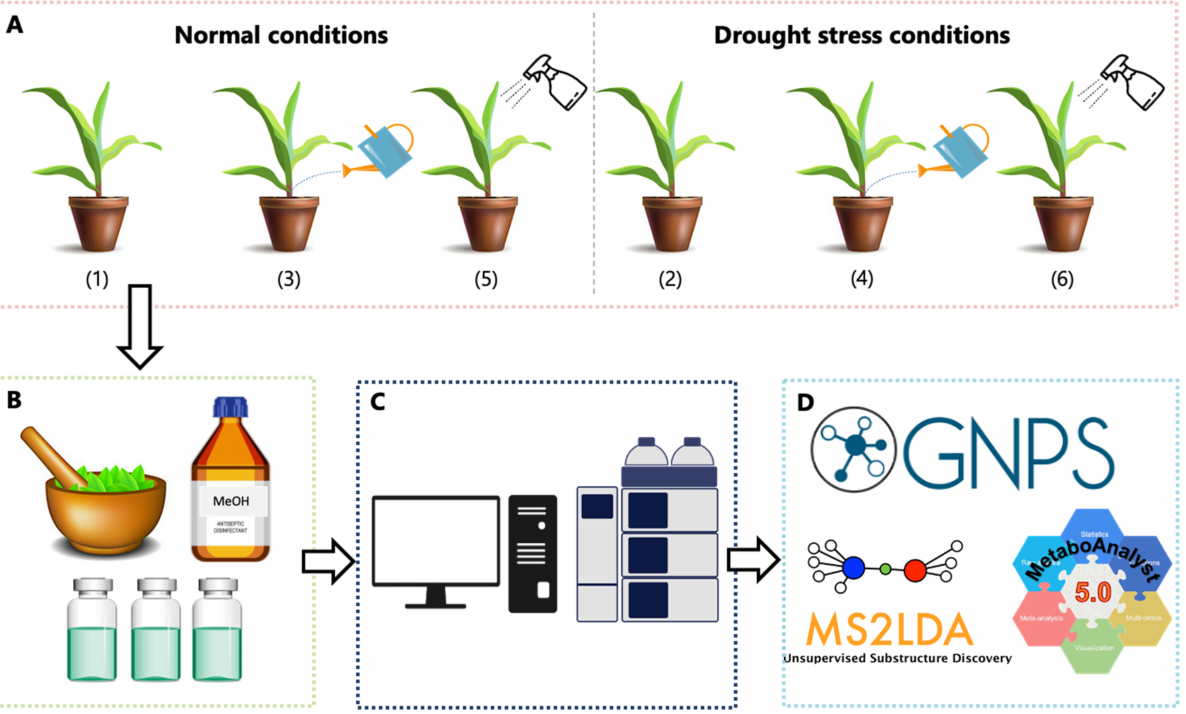
Figure 1. Schematic overview of the study design. ( A ) Maize plants were divided into 6 groups, with each group comprised of 5 maize plants (biological replicates) to make up a total of 30 plant samples. Control groups consisted of untreated maize plants under (1) normal and (2) drought stress conditions. Treatment groups consisted of soil application of seaweed-based biostimulant under (3) normal and (4) drought stress conditions, and foliar application of seaweed-based biostimulant under (5) normal and (6) drought stress conditions. Leaves were harvested at four time points (1 day, 3-, 7-, and 14 days after treatment) followed by ( B ) metabolite extraction and sample preparation; ( C ) Extracts were analyzed with liquid-chromatography mass-spectrometry (LC–MS/MS); ( D )